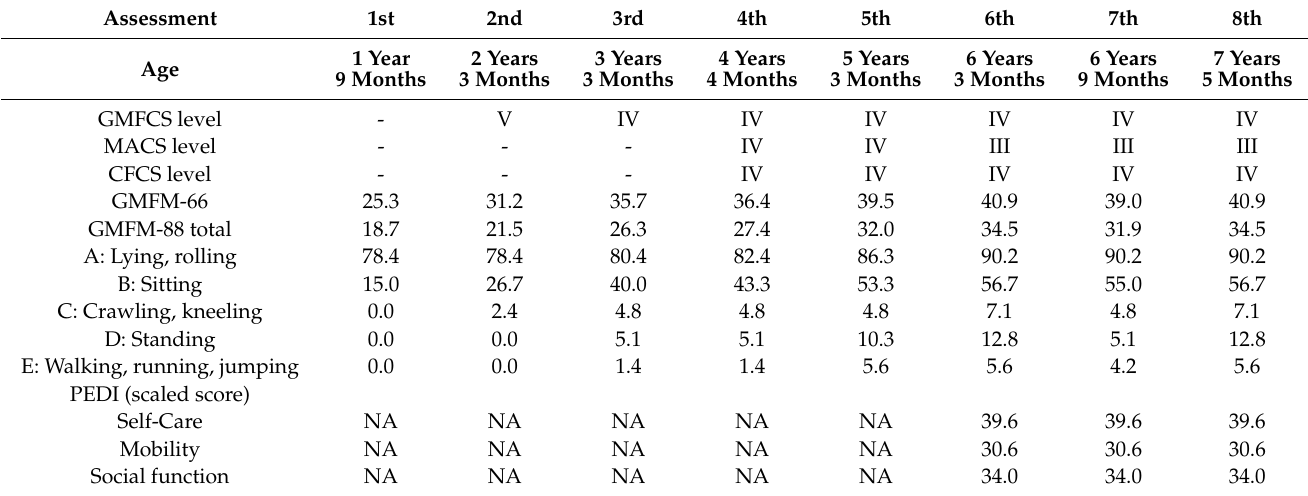
Table 2. Developmental course and changes in motor function of the patient.